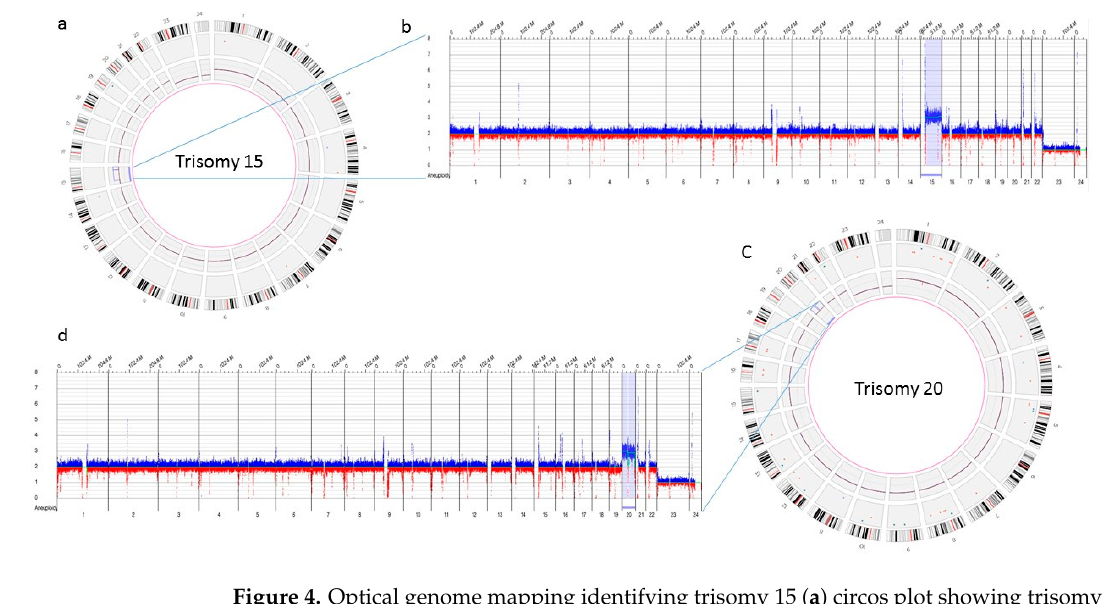
Figure 4. Optical genome mapping identifying trisomy 15 ( a ) circos plot showing trisomy 15 ( b ) copy number track view with trisomy 15, ( c ) circos plot showing trisomy 20 ( d) copy number track view with trisomy 20. Table 2. Abnormal genetic aberrations detected with SNP microarray and optical genome mapping on the product of